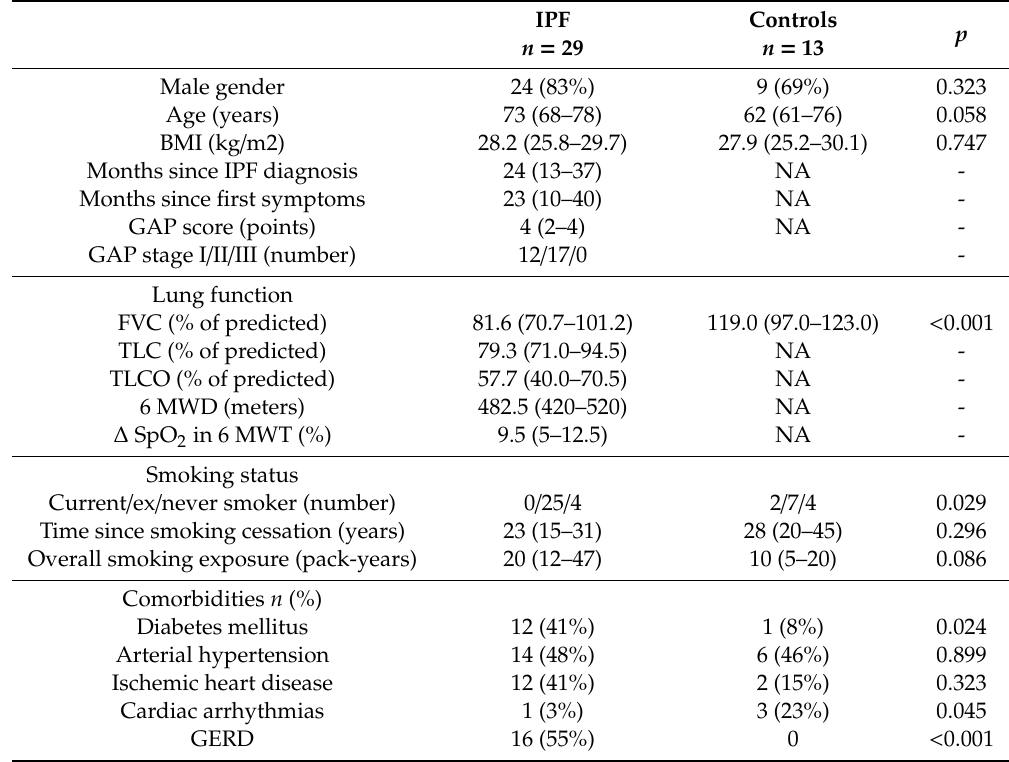
Table 1. Baseline characteristics of the study